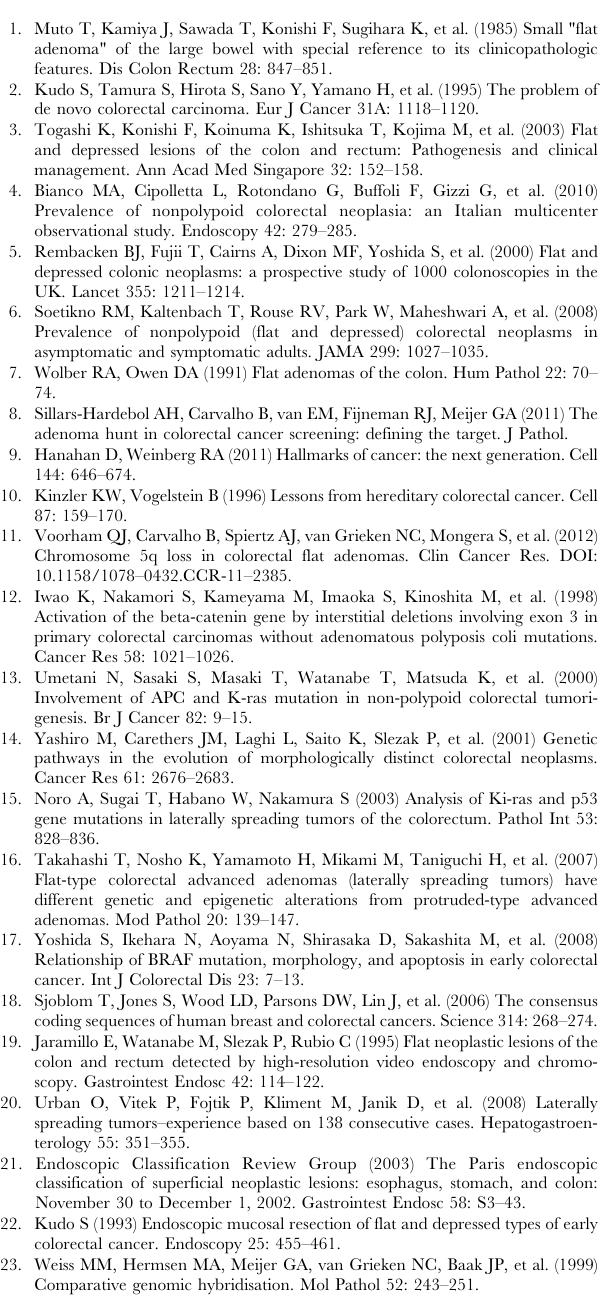
Table S3 Overview of all mutated samples.